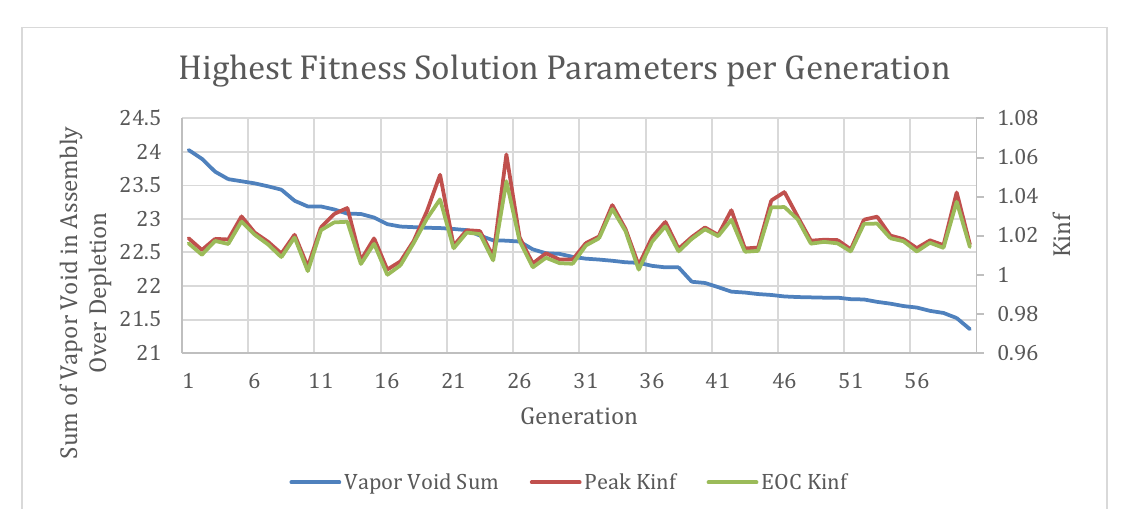
Figure 3. Parameters for highest fitness solution for each generation in the optimization.